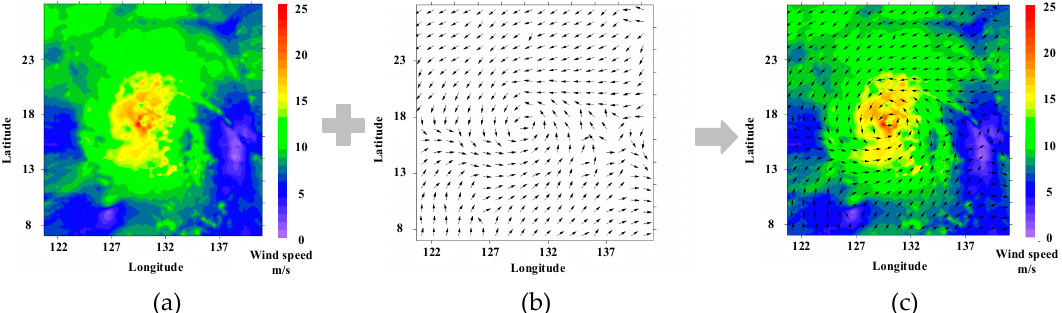
Figure 3. Schematic diagram of the wind field process: ( a ) wind speed map; ( b ) wind direction map; ( c ) wind field map.